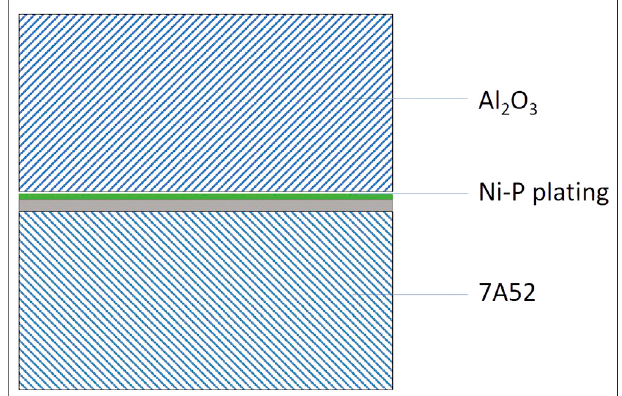
FIGURE 1 | Assembly structure